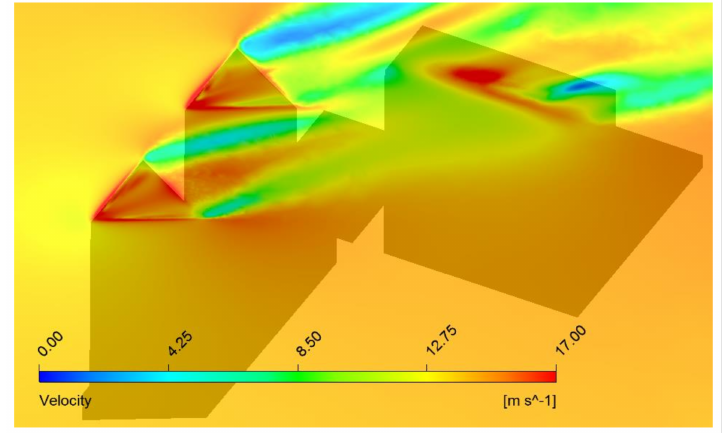
Figure 20. Streamlines of wind speed 1 m above roof surface for possible wind turbine placement.